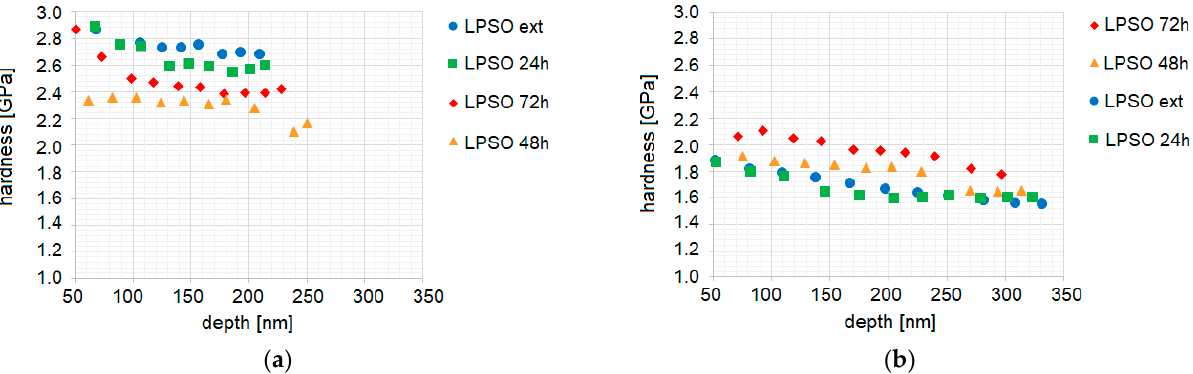
Figure 14. Hardness of the multi ‐ cycle indents up to 2 mN in Mg ‐ Dy ‐ Nd ‐ Zn ‐ Zr alloy in the as ‐ extruded and the solution heat ‐ treated conditions at 500 °C for 24 h, 48 h, and 72 h: in the blocky LPSO phases ( a ) and in the matrix without LPSO lamellae ( b ).